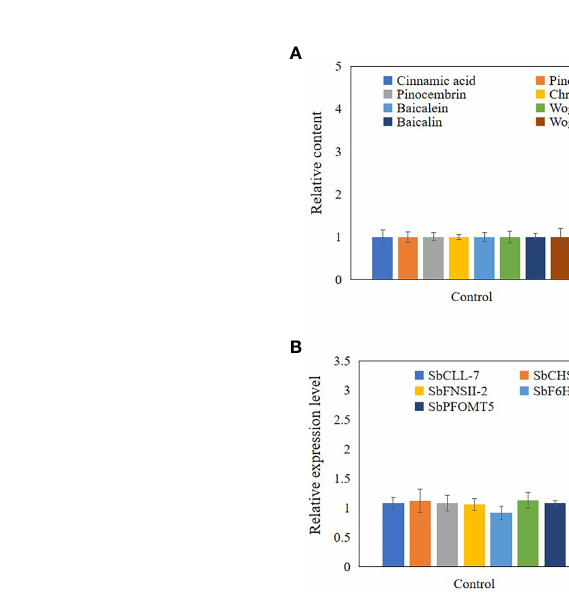
FIGURE 3 Content and expression level of metabolites and enzymes related to 4'-deoxy fl avones biosynthesis in hydroponic Scutellaria baicalensis roots with treatment of MeJA. (A) , relative content of metabolites related to 4'-deoxy fl avones biosynthesis. The data are the means ± SDs (n = 5), *means means p < 0.05, **means p < 0.01. (B) , relative expression level of enzymes related to 4'-deoxy fl avones biosynthesis. The data are the means ± SDs (n = 3), *means means p < 0.05, **means p < 0.01.